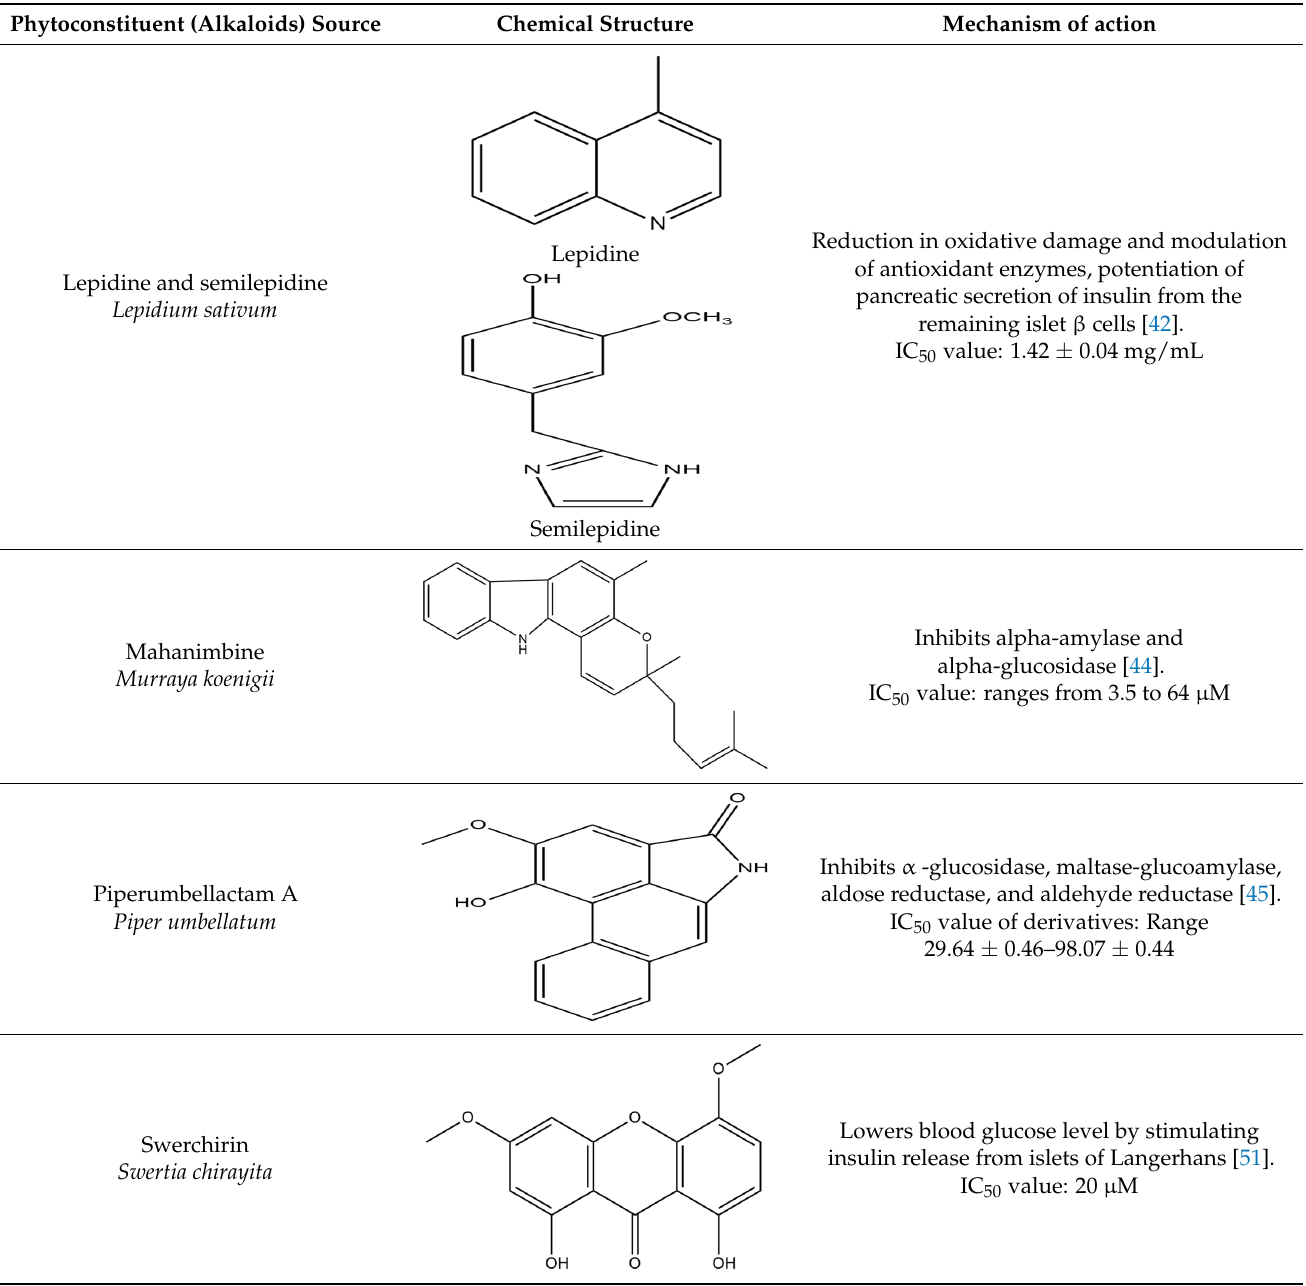
Lowers blood glucose level by stimulating insulin release from islets of Langerhans [51]. IC 50 value: 20 μ M